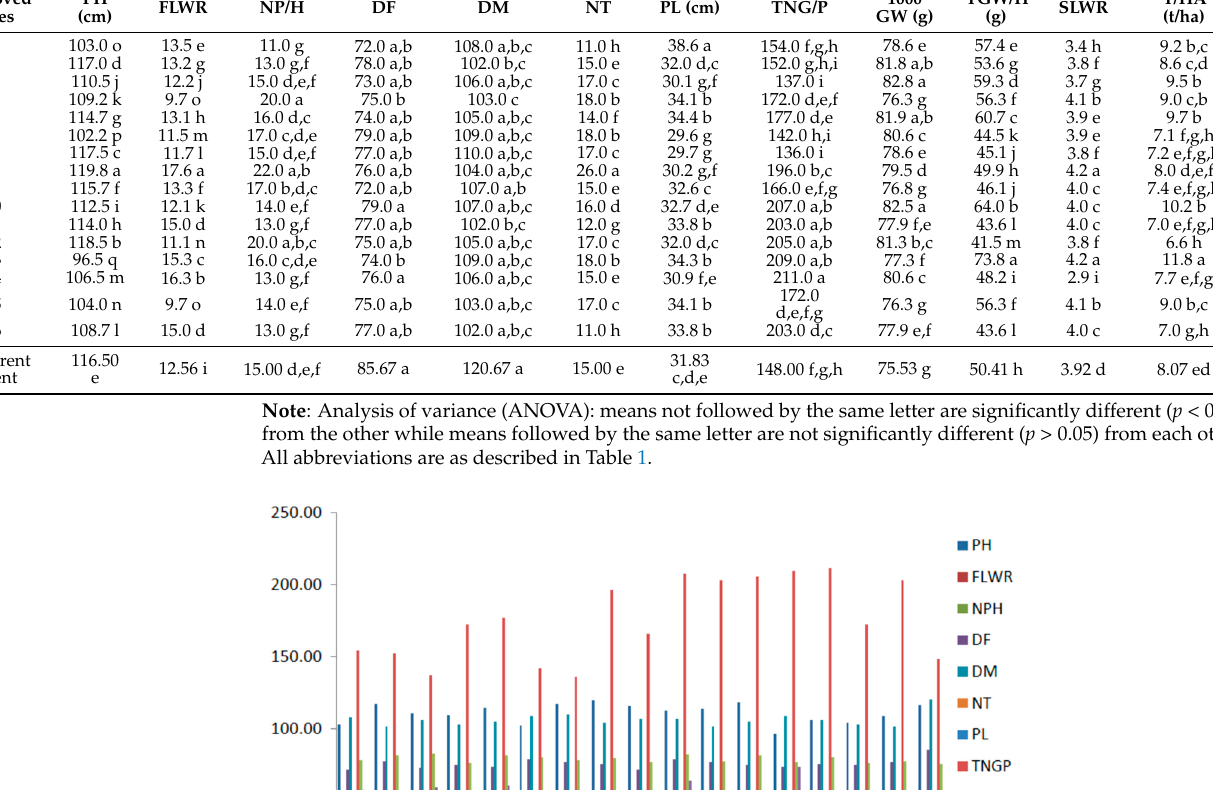
Figure 3. Phenotypic expression of the newly improved and parental lines. Note: ( A ) improved line, ( B ) recurrent parent and ( C ) parental and Improved lines. 3.3. Trait Variation and Correlation The results of bacterial leaf blight and blast screening of BC 2 F 2 progenies are pre- sented in Table 5. The Chi-square result showed a non-significant difference ( p > 0.05) in